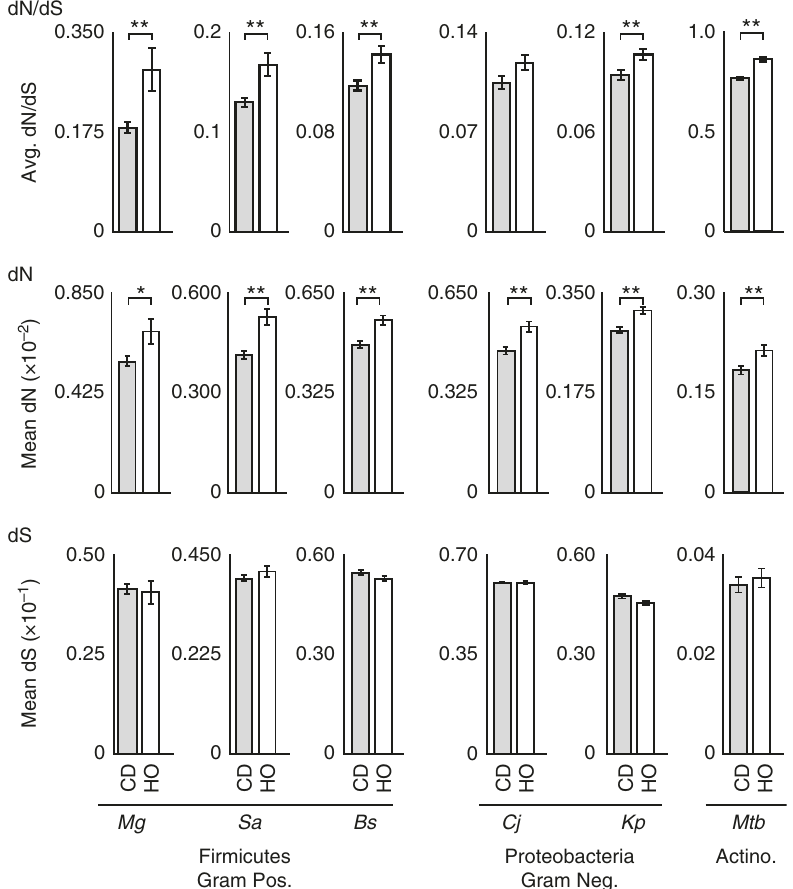
Fig. 4 Head-on genes evolve at an accelerated rate across phyla. Whole-genome mutational analysis including the dN/dS ratio, rate of non-synonymous mutations (dN), and rate of synonymous mutations (dS) are shown. Values were calculated for core genes that are ≥ 95% conserved in both length and amino acid sequence using at least 10 complete genomes per species. Additional species information including naming abbreviations and the number of core genes analyzed per species are available in Supplementary Table 2. Error bars represent the standard error of the mean. Statistical signi fi cance was determined by the two-tailed Z -test. * p < 0.05. ** p <